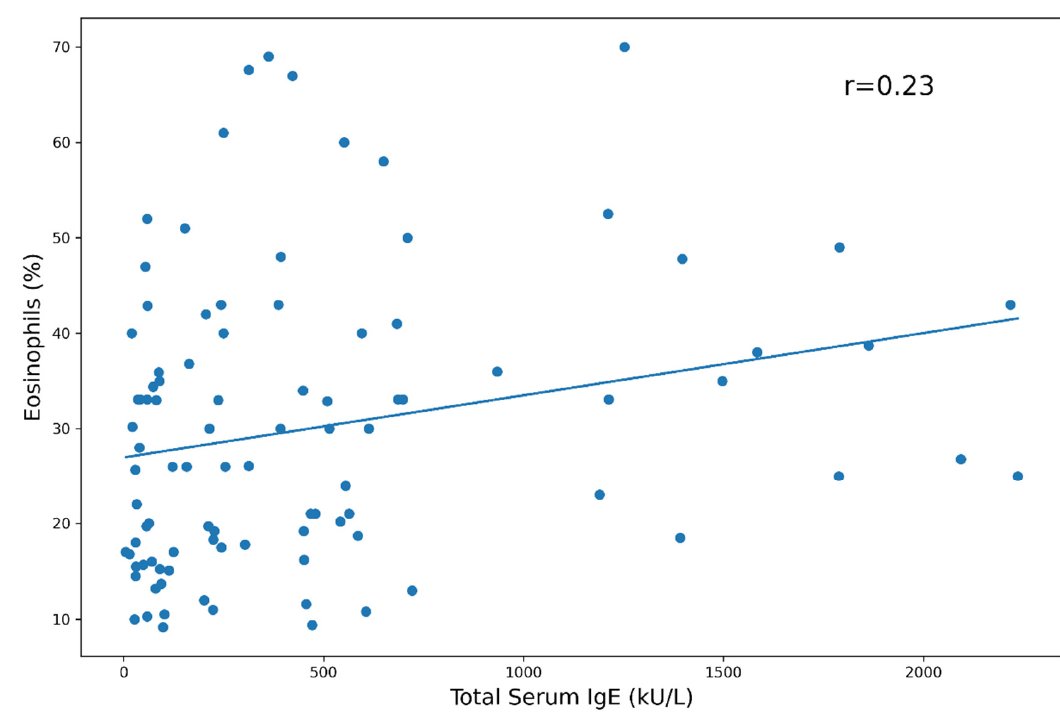
Figure 6. Eosinophils percentage vs. total IgE.